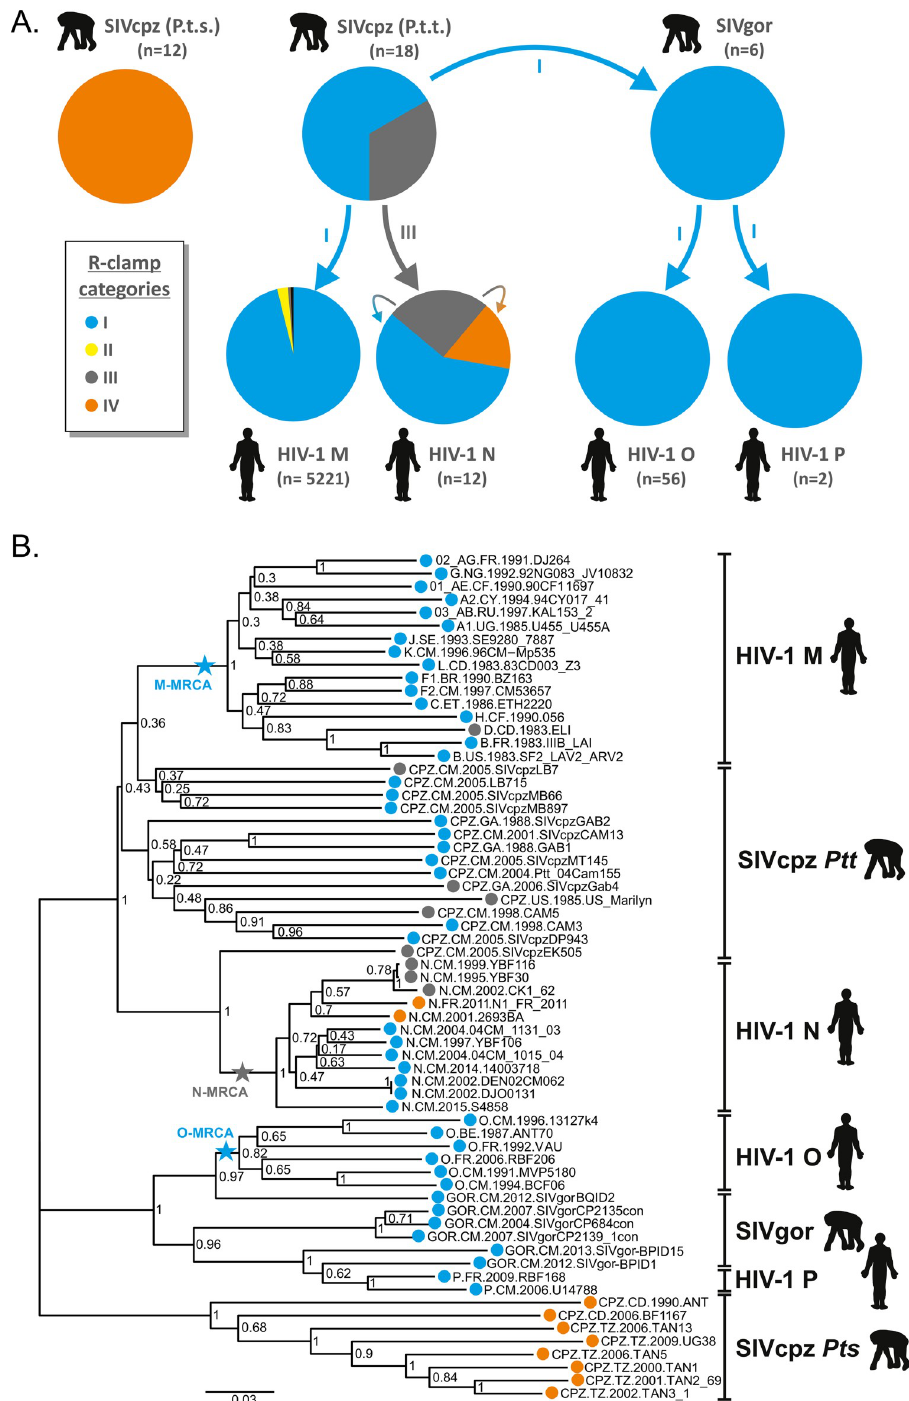
Fig 9. Putative cross-species transmission and evolution of R-clamp categories. The pie charts on the left illustrate the relative fraction of each R-clamp category in SIVcpz, SIVgor and HIV-1 groups M, N, O and P. Putative cross- species transmission events are indicated by colored arrows. The lower part of the figure shows a phylogenetic analysis of selected primate lentiviral Nefs is shown. Inferred most recent common ancestors are indicated by stars. In both images, R-clamp categories I, II, III, and IV are shown in blue, yellow, grey and orange, respectively.